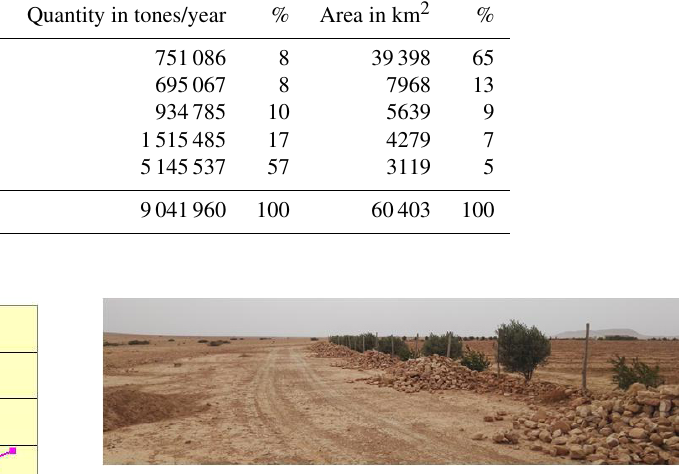
Figure 4. Evolution of Mohammed V dam’s siltation (Extension of agricultural space and its removal by stone removal, which con- tributes to erosion (1 August 2017, national road no 19. Plain of